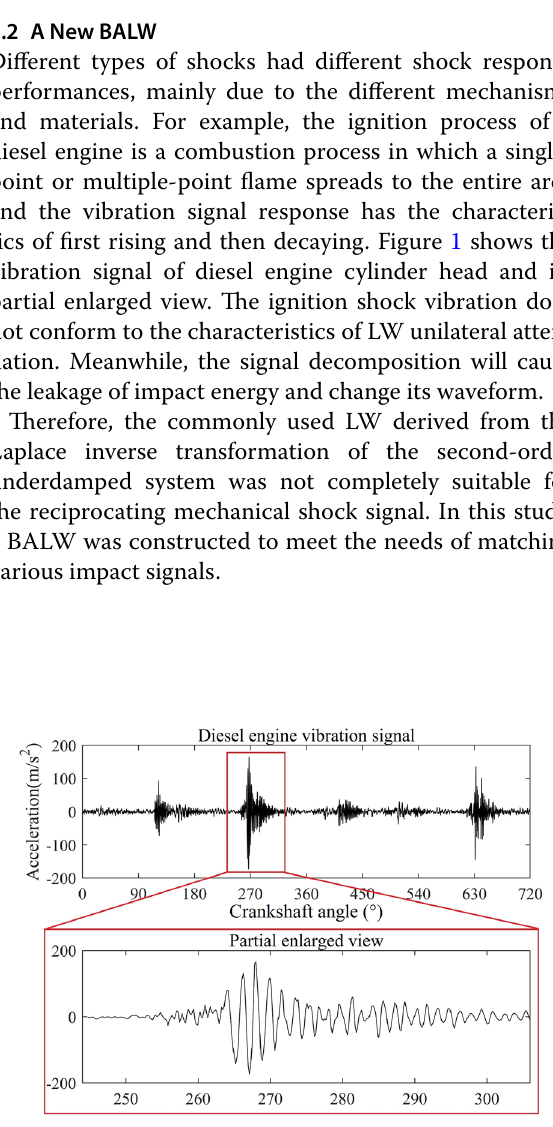
Figure 1 Diesel engine vibration signal and partial enlarged